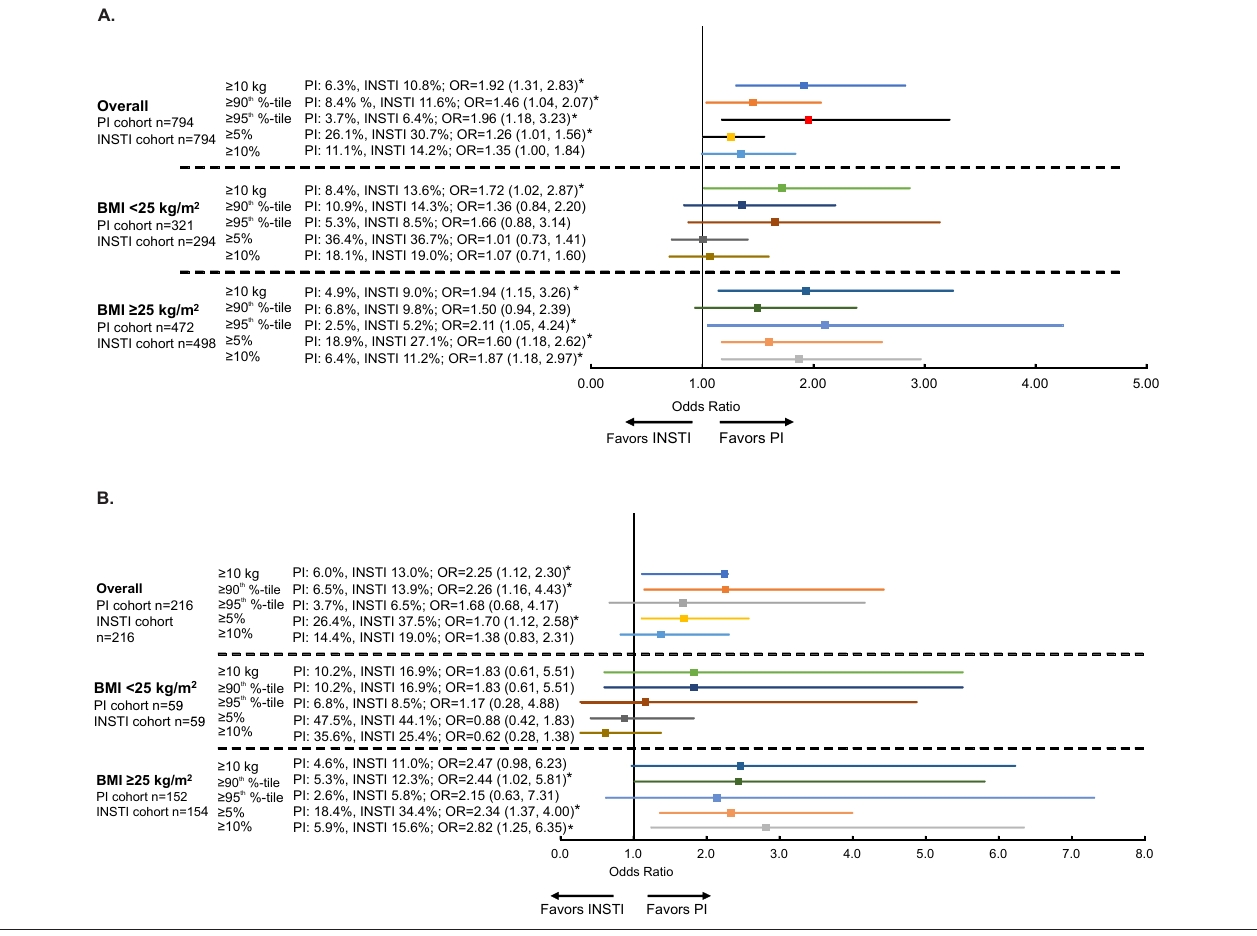
Figure 3. Proportion of Patients with Weight Gain, Overall and by BMI